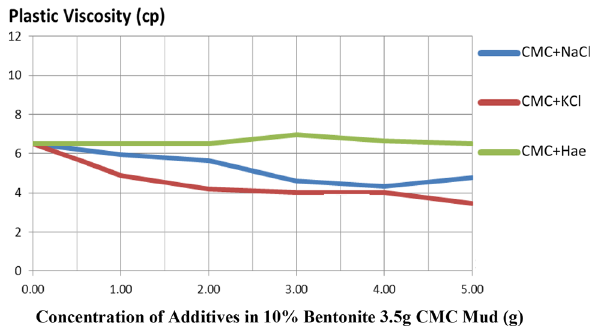
Fig. 5 Effect of NaCl, KCl and haematite on apparent viscosity of CMC–bentonite mud